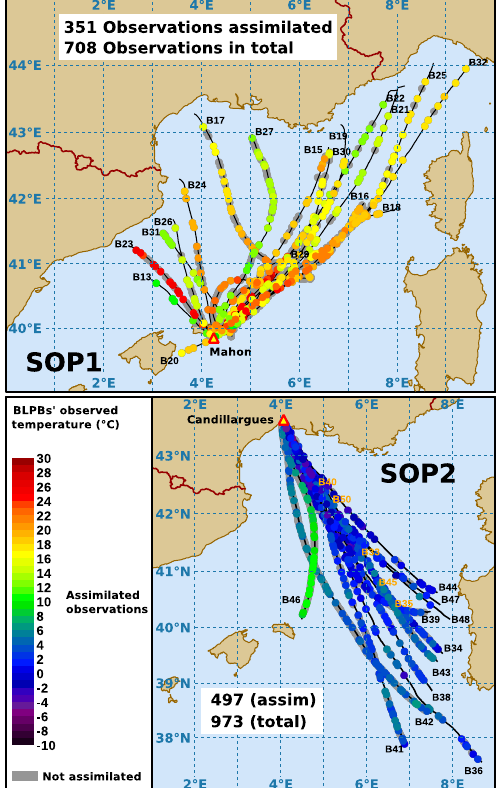
Figure 4. Trajectories of the 18 assimilated boundary layer pressur- ized balloons (BLPBs) during SOP1 (top) and of the 16 assimilated BLPBs launched during SOP2